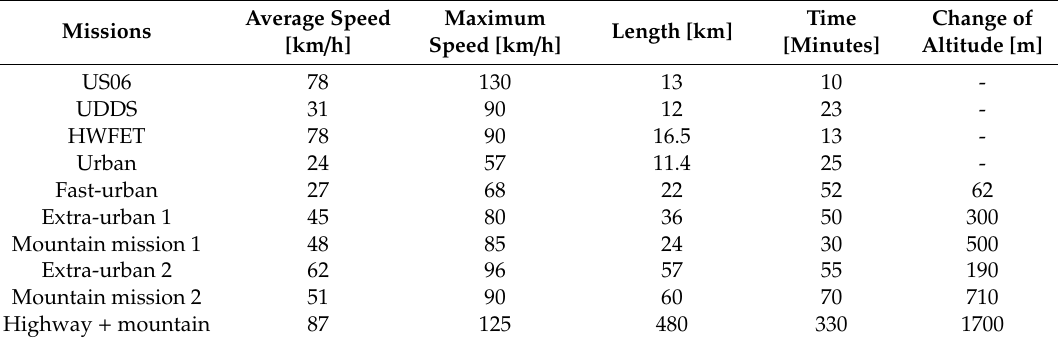
Table 2. Road mission features.